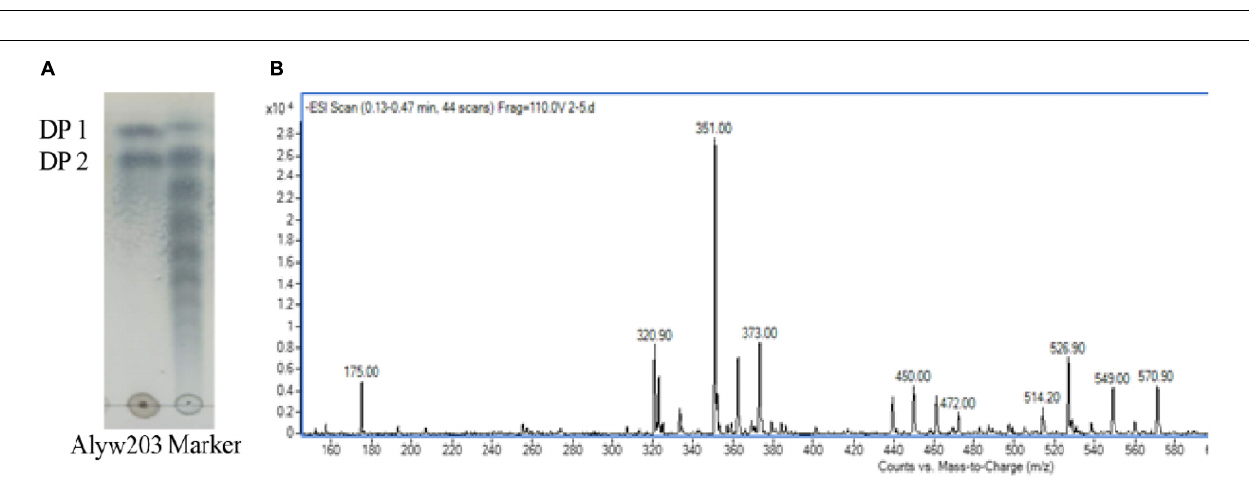
FIGURE 8 | Degradation product analysis of Alyw203 by (A) TLC: Lane Alyw203, hydrolytic products of Alyw203; Lane Marker, standard alginate oligosaccharides; and (B) ESI-MS.